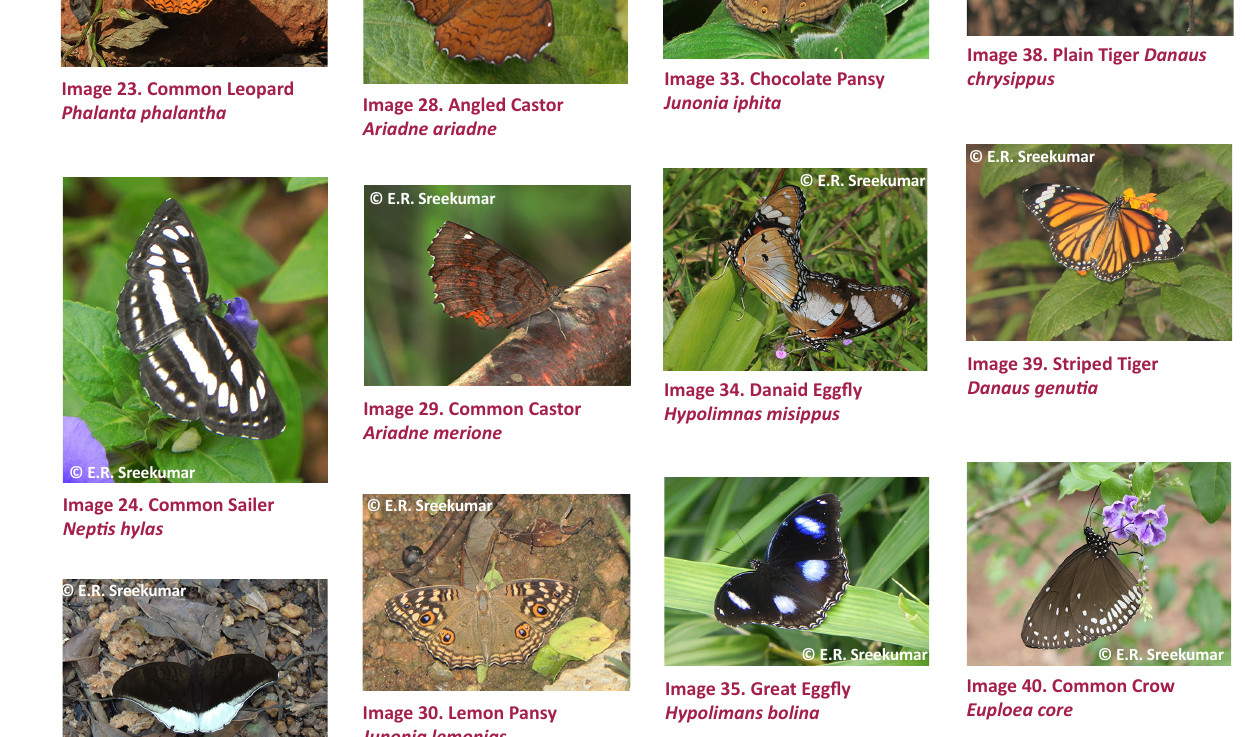
Image 40. Common Crow Euploea